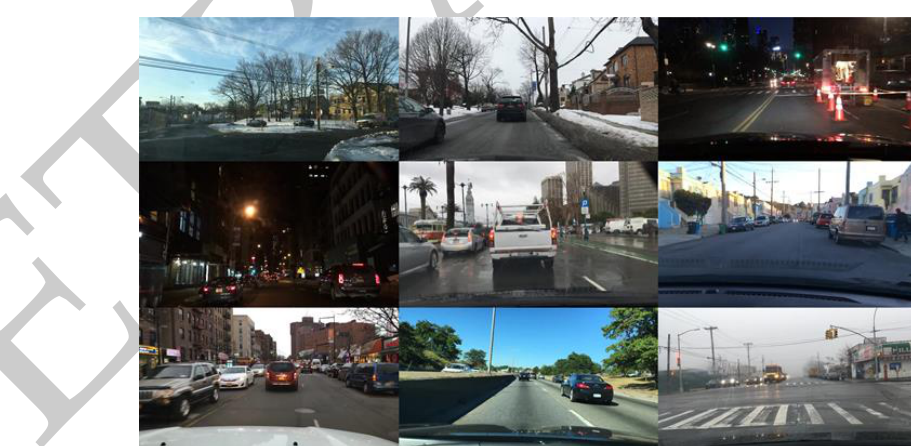
Figure 7. A snapshot of multiple images from the Berkeley Deep Drive (BDD100K) dataset.